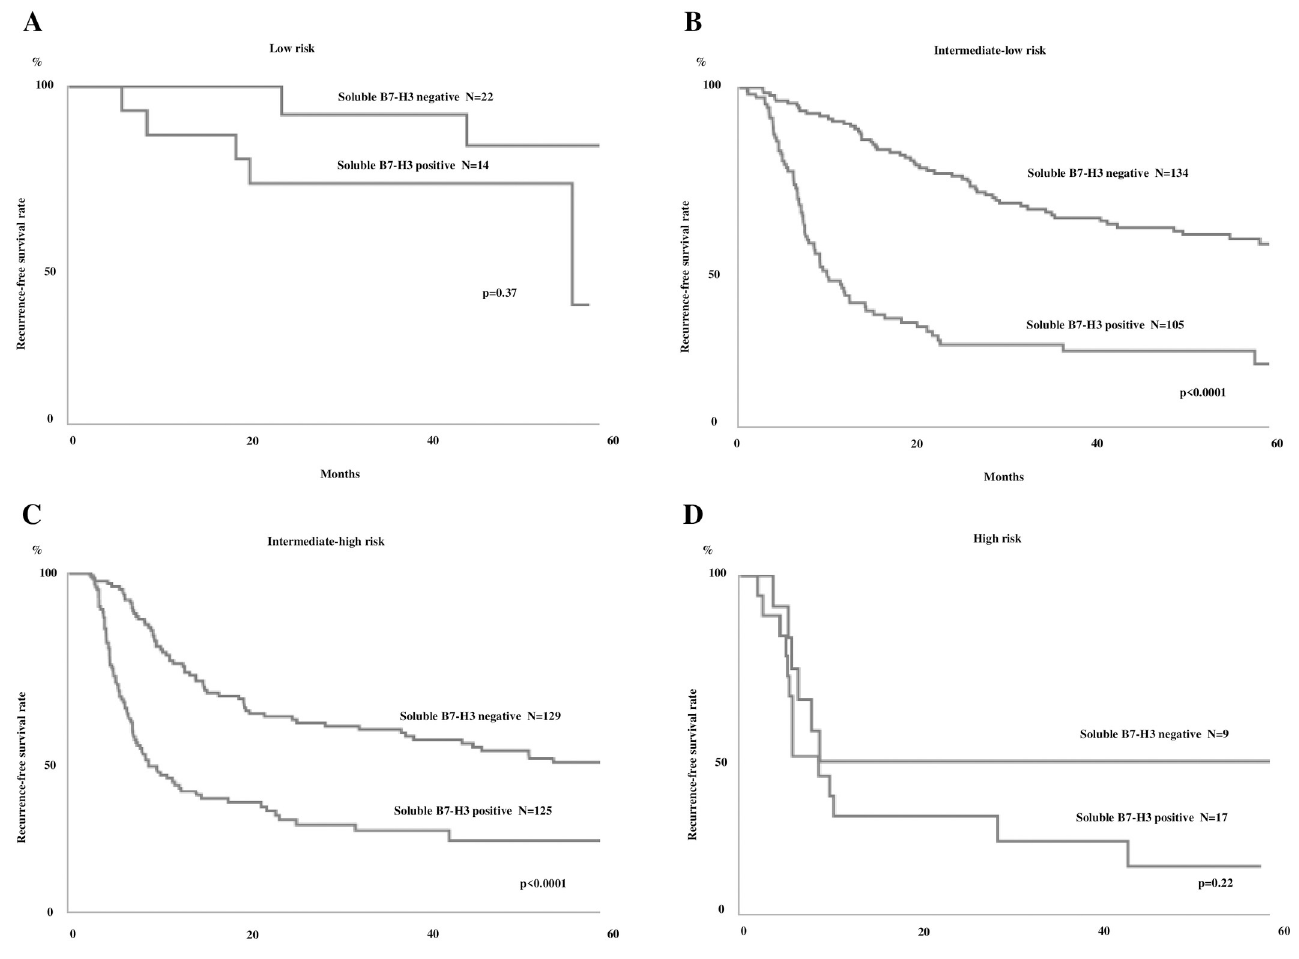
Fig 3. Kaplan-Meier recurrence-free survival rate curves for patients with non-muscle invasive bladder cancer (NMIBC) classified by the EORTC risk table for recurrence. All the groups were further divided according to the presence of serum soluble B7-H3. The figures show the low (A), intermediate-low (B), intermediate-high (C), and high (D)-risk